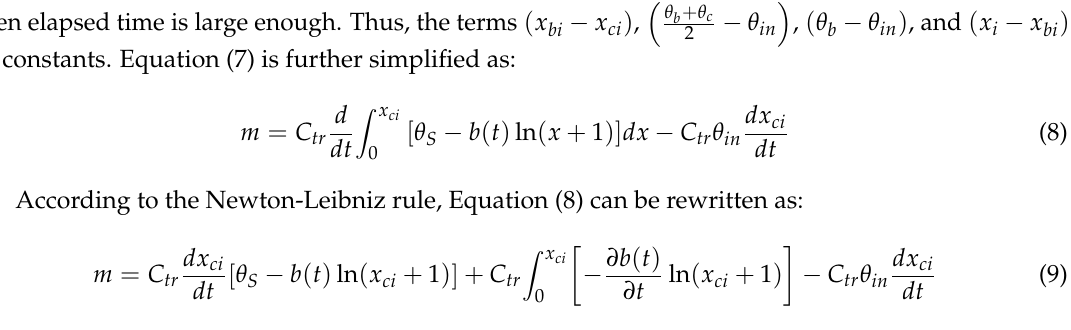
Figure 3. Soil moisture profiles simulated with the improved modified Green–Ampt (IMGA) model over time (the dashed line is the soil moisture profile at time i , and the solid line is the moisture profile at a later time f ). θ b is critical soil moisture in the middle of WZ (m 3 /m 3 ), θ 3 ( x ) is soil moisture profile function connected with WF in the wetting zone (m 3 /m 3 ), x bi is advancement distance of the point of intersection of two linear functions in the wetting zone (m).